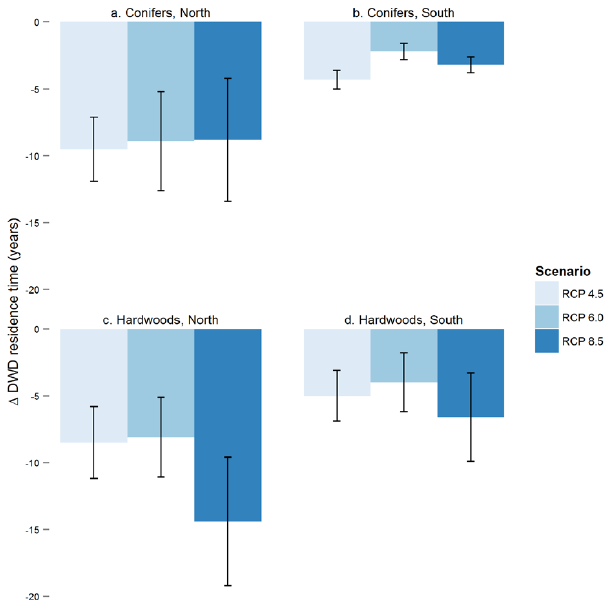
Figure 2. Decreases in downed woody debris (DWD) residence time compared to baseline scenario. Mean values by species group and region in eastern US forests for a baseline current-climate scenario and assuming changes in future climate (based on three RCP scenarios from an ensemble of 17 CMIP5 models). Error bars indicate one standard deviation.